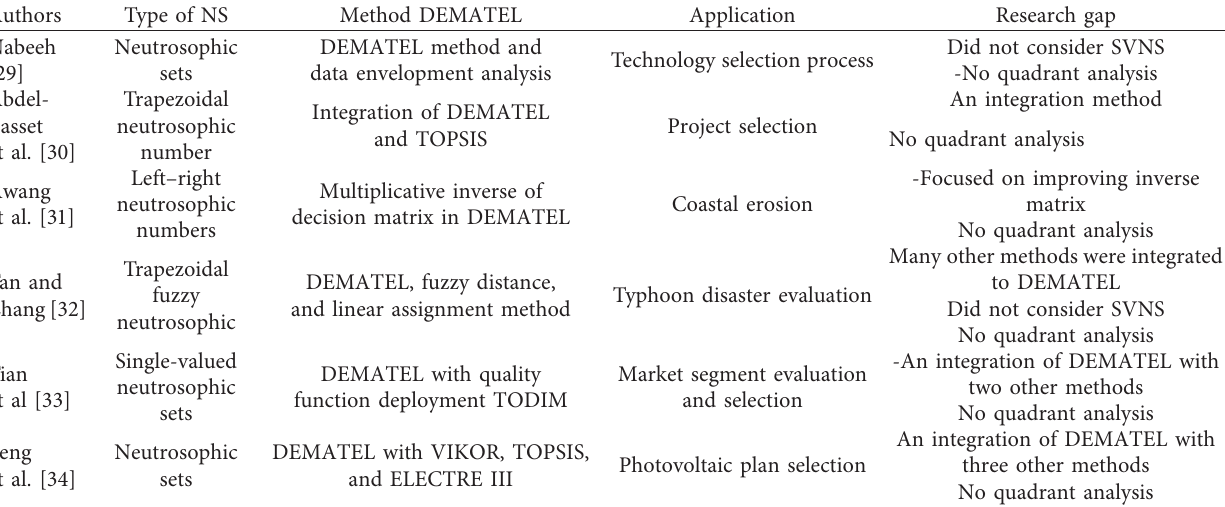
Table 1: Summary of related researches and research